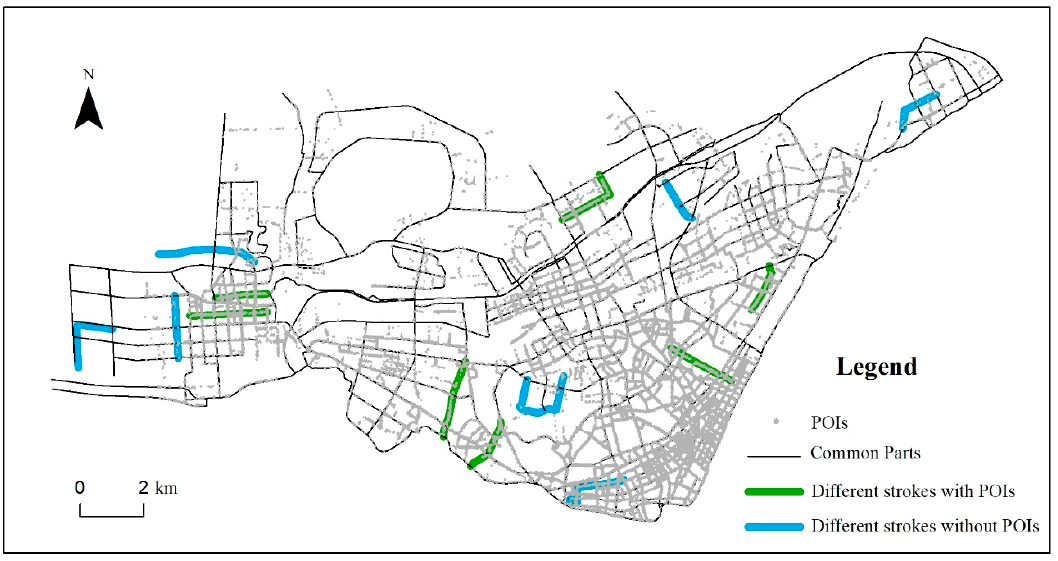
Figure 11. Comparison between the results with and without the constraint of POIs. The green strokes tend to be surrounded by more POIs, compared to blue strokes, indicating that our method can preserve more roads with relatively significant contextual characteristics.